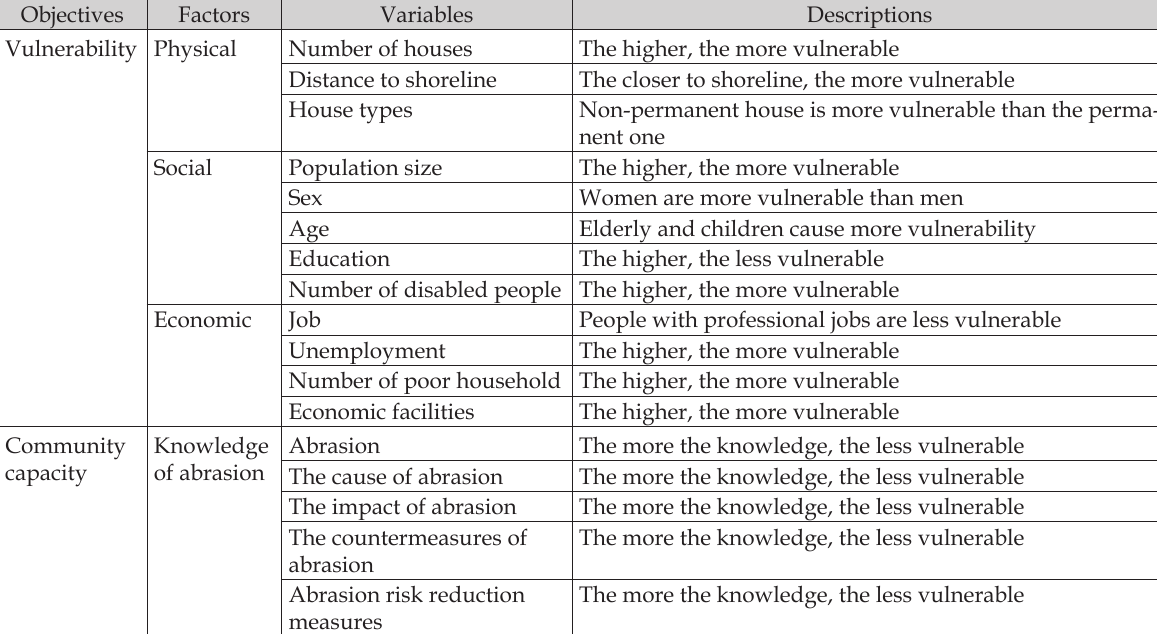
Table 1. Research variables.